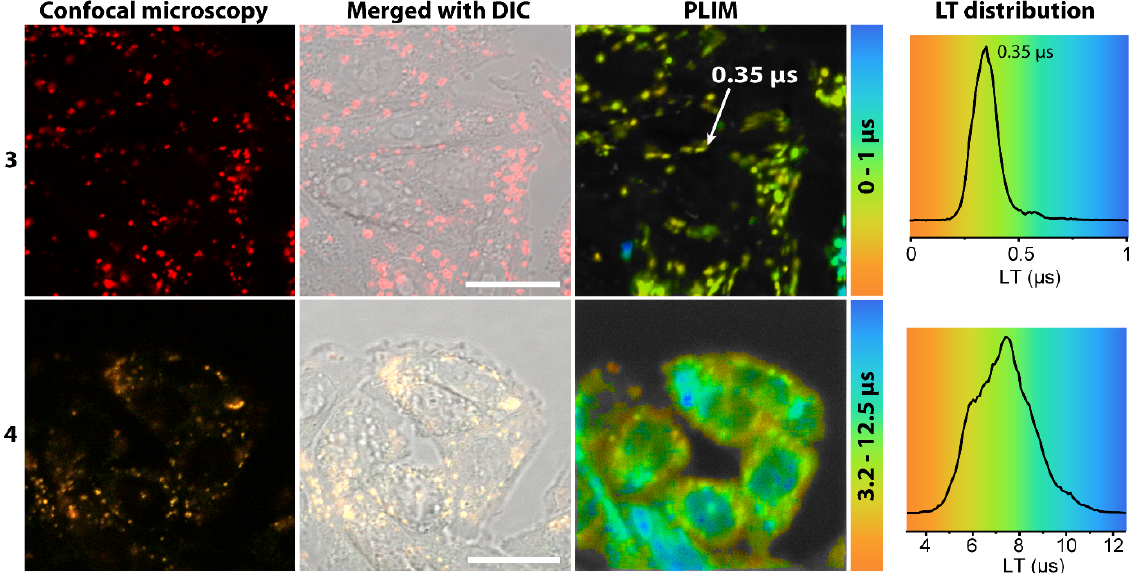
Figure 10. Confocal and PLIM-images of CHO-K1 cells incubated with complex 3 (Top, 5 µM, 24 h) and 4 (Bottom, 25 µM, 24 h). Left : confocal image and merged confocal image and DIC. Central: PLIM image. Right : lifetime distribution for the PLIM image. Excitation 405 nm, 37 °C and 5% CO 2 , normoxia.